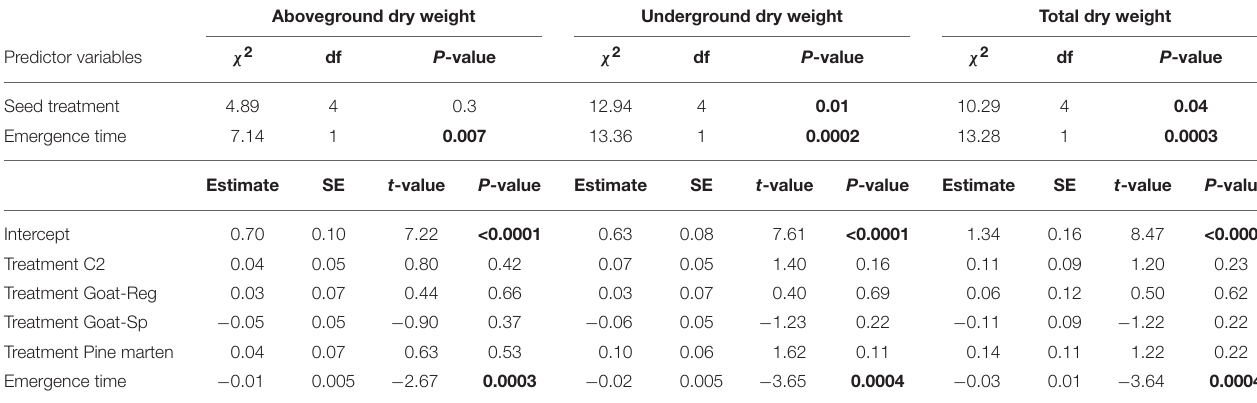
TABLE 4 | Main results of the linear mixed models testing the effects of seed treatment (C1 or “control seeds with pulp”, C2 or “manually-depulped control seeds”, Goat-Reg or seeds regurgitated by goat, Goat-Sp or seeds spit out by goat, and Pine marten or pine marten-ingested seeds) and emergence time (predictor variables) on seedling growth: aboveground, underground, and total seedling dry weight (response variable). Aboveground dry